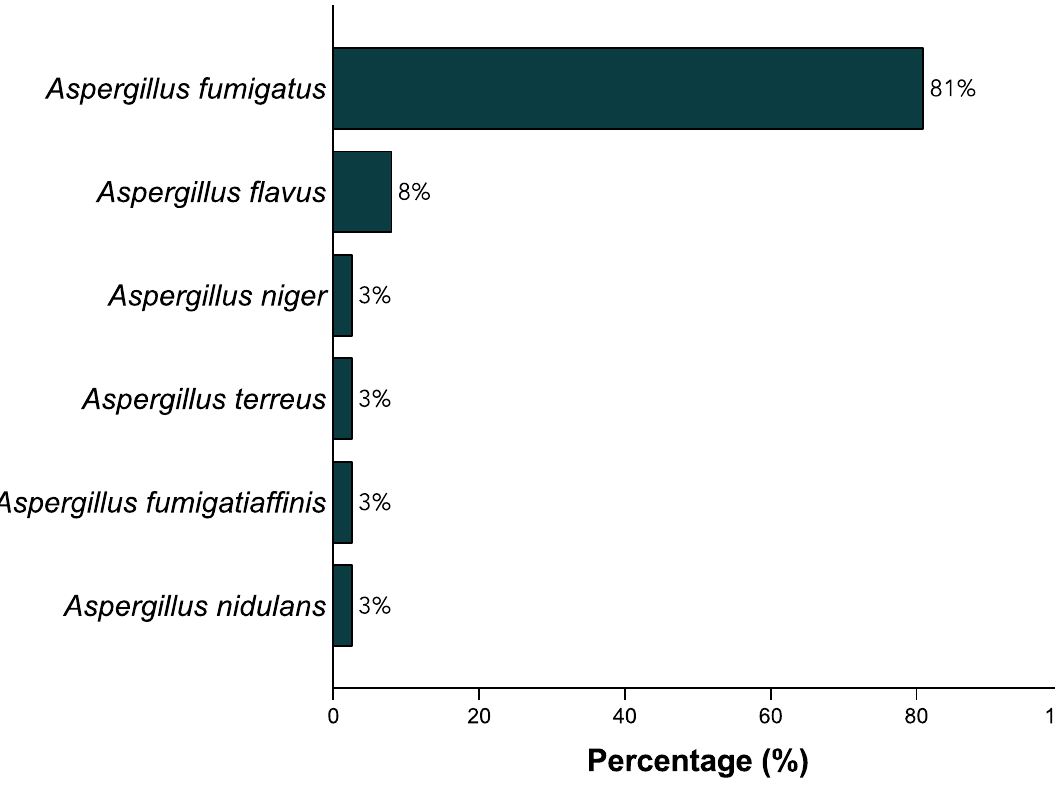
Figure 3. Relative frequencies (%) of strains identified in BAL samples .